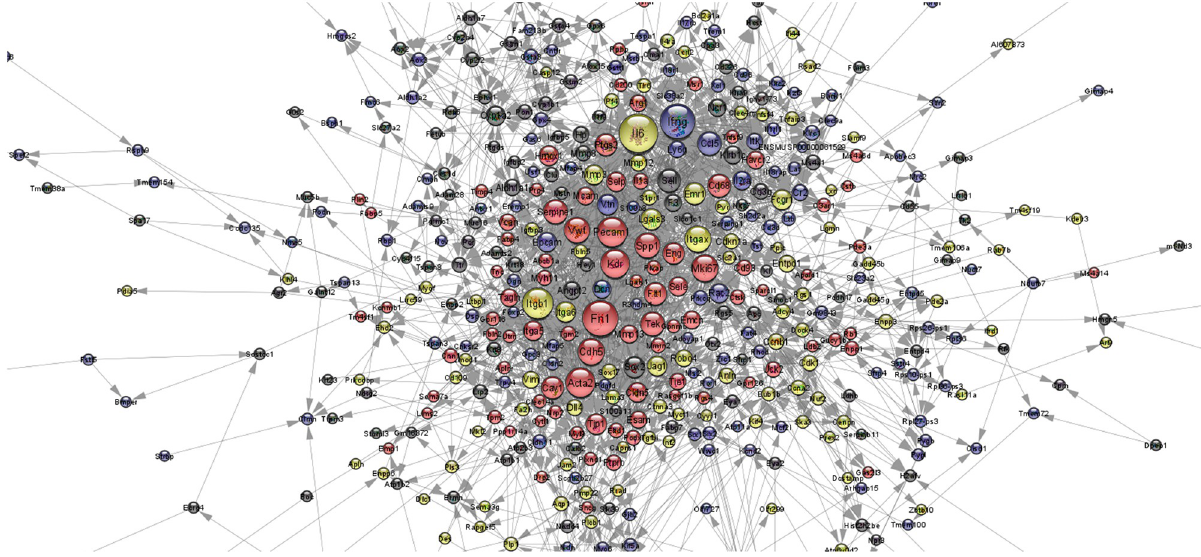
Fig 6. Interaction degree of the protein–protein interaction (PPI) network assessed via Cytoscape using the Search Tool for the Retrieval of Interacting Genes (STRING) plug-in. The interaction degree of the PPI network is shown based on significantly differentially expressed genes (fold change � 2 and p � 0.05). Near red color indicates upregulation, and near black color indicates downregulation; the larger the circle, the larger the value of interaction degree. ( n = 3 for each group).